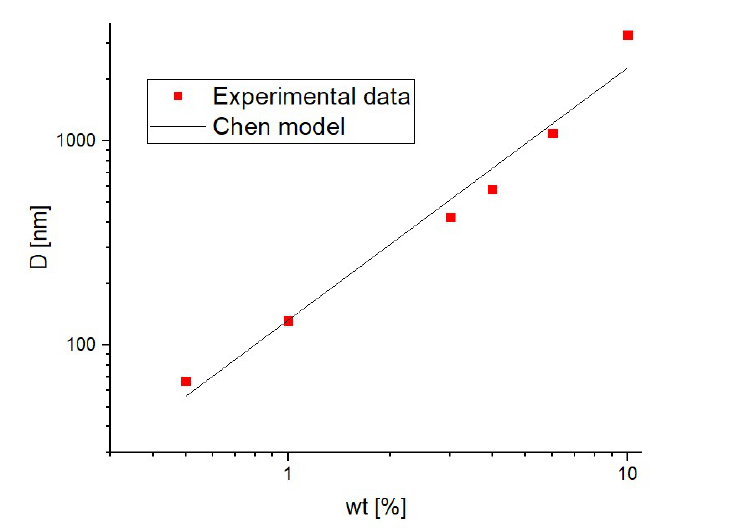
Figure 1. Film thickness dependence on PSAN concentration: experimental (squares) and model fit (solid line).